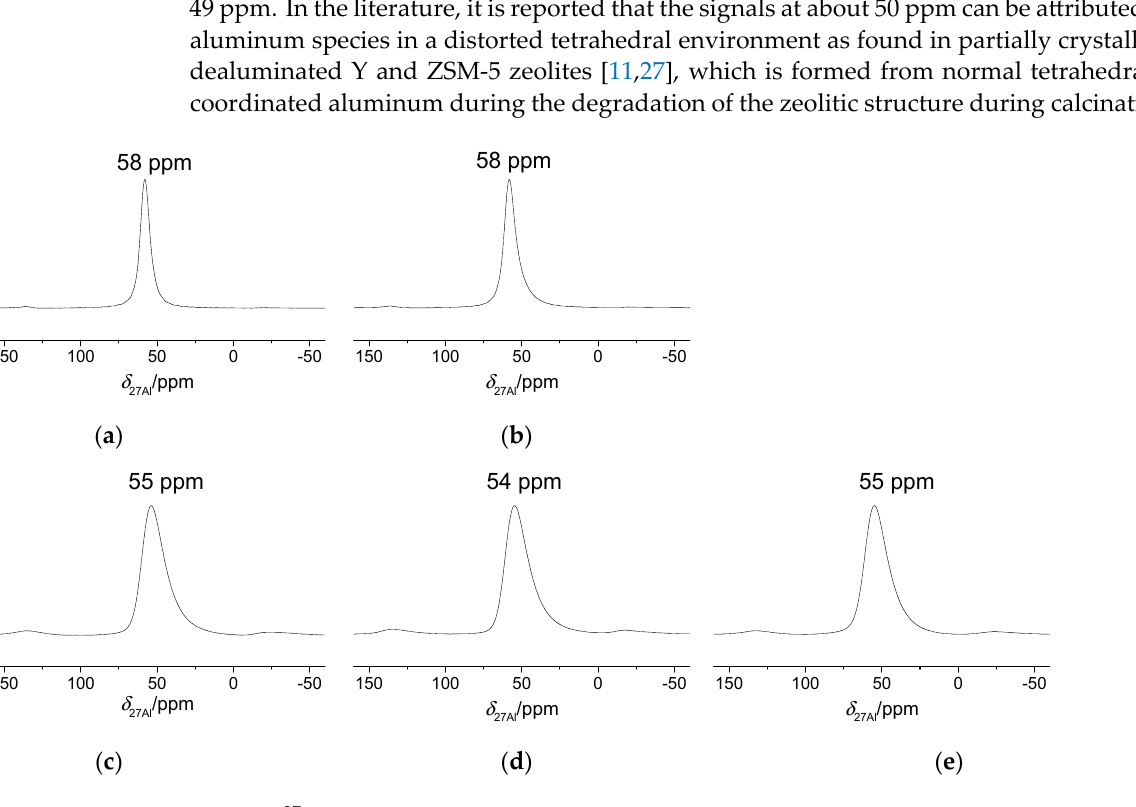
Figure4. 27 Al MAS NMR spectra of the hydrated zeolites. ( a ) Na,K‑PHI_hs_a.s._90%; ( b )